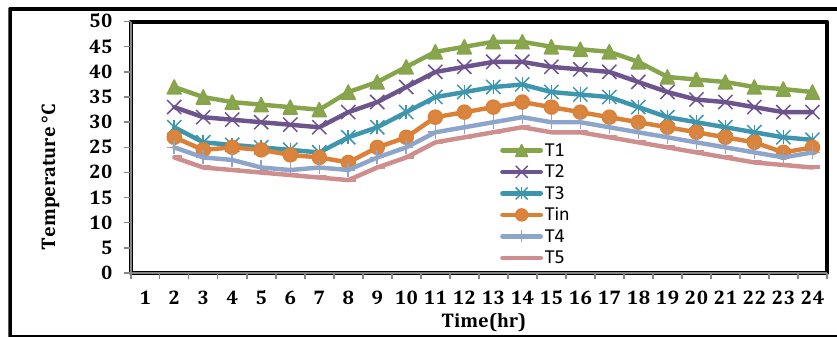
Figure 8: Process temperature in summer as shown in Figure 3.